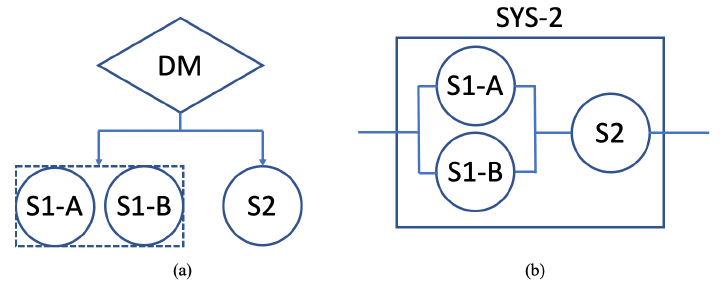
Figure 6. Sample system (System-2) with one decision maker (DM) and three sensors, S1-A, S1-B, and S2. ( a ) System diagram as DM relies on three sensors, where S1-A and S1-B are used for the same information. ( b ) Logic representation, where S1-A and S1-B are connected in parallel and are connected to S2 in series.